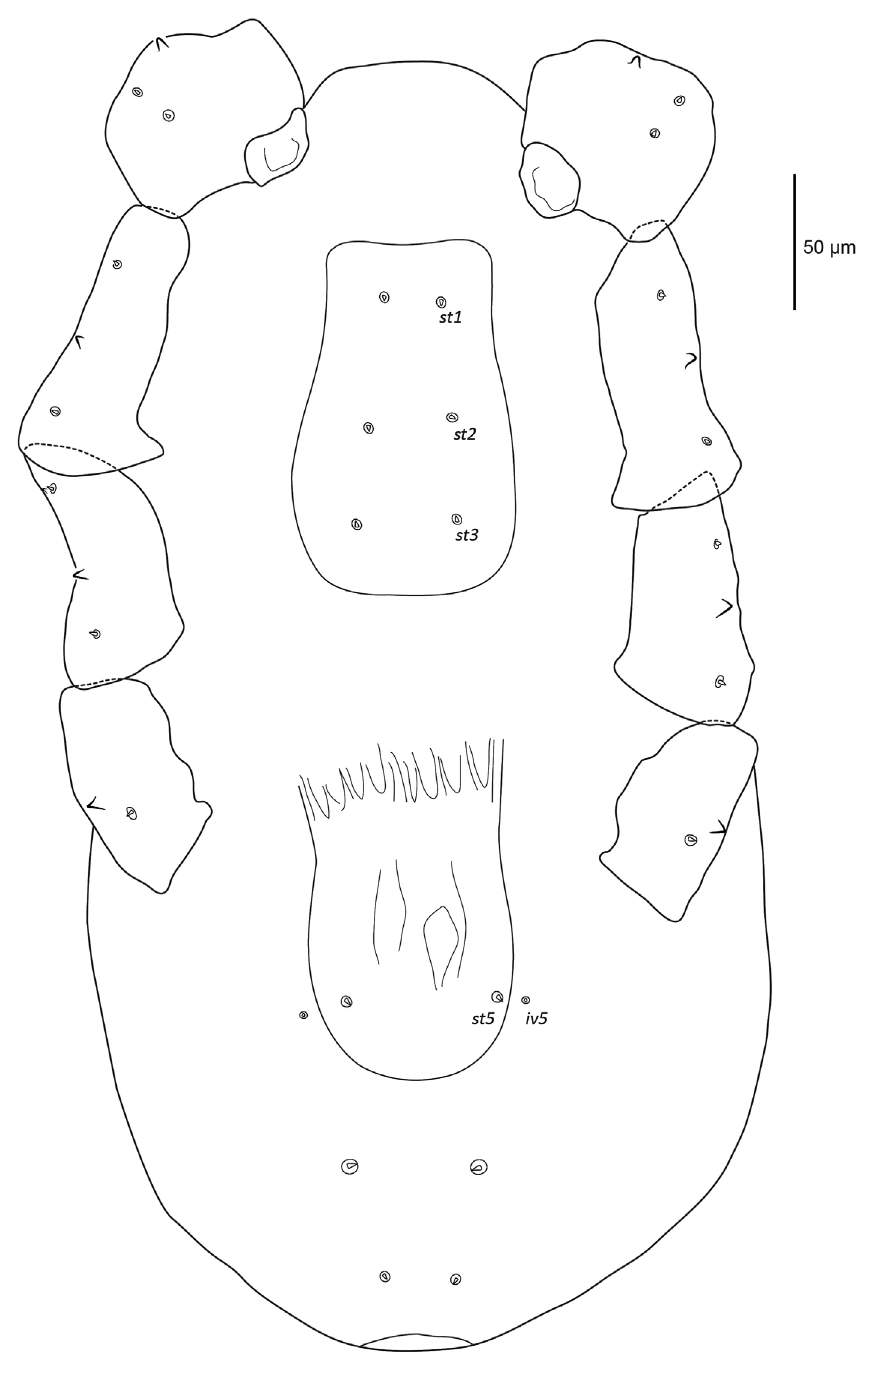
Figure 3. Female Sternostoma gallowayi sp. n. ventral idiosoma including